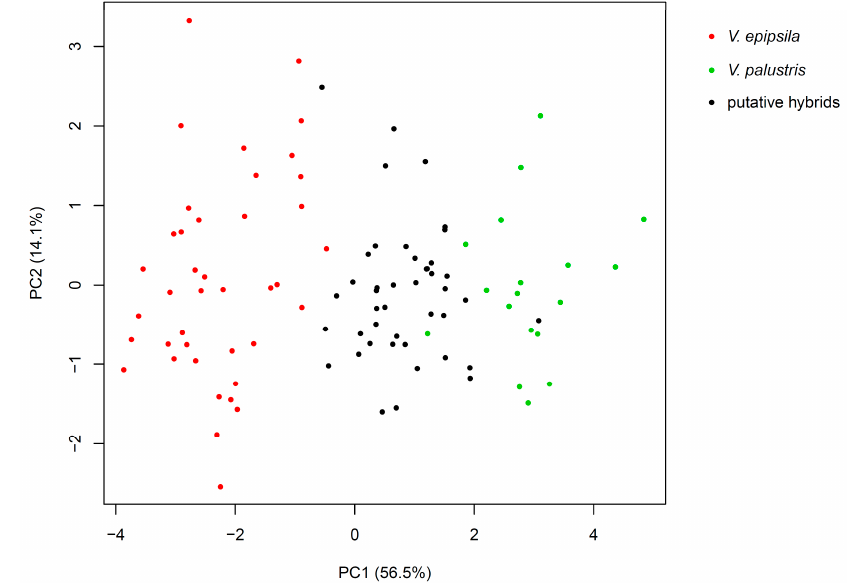
Figure 4. Principal component analysis (PCA) of quantitative features (feature description in “Materials and Methods”).